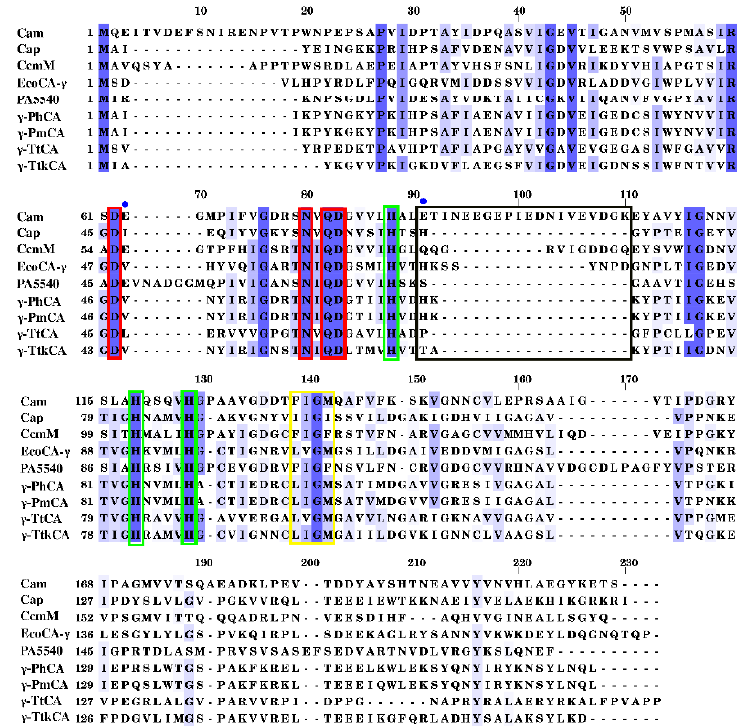
Figure 1. Multiple sequence alignment of the γ -CA sequences performed by PROMALS3D alignment